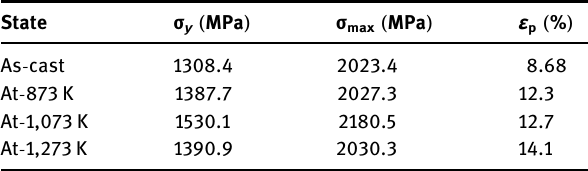
Table 4: Room temperature compression performance parameters